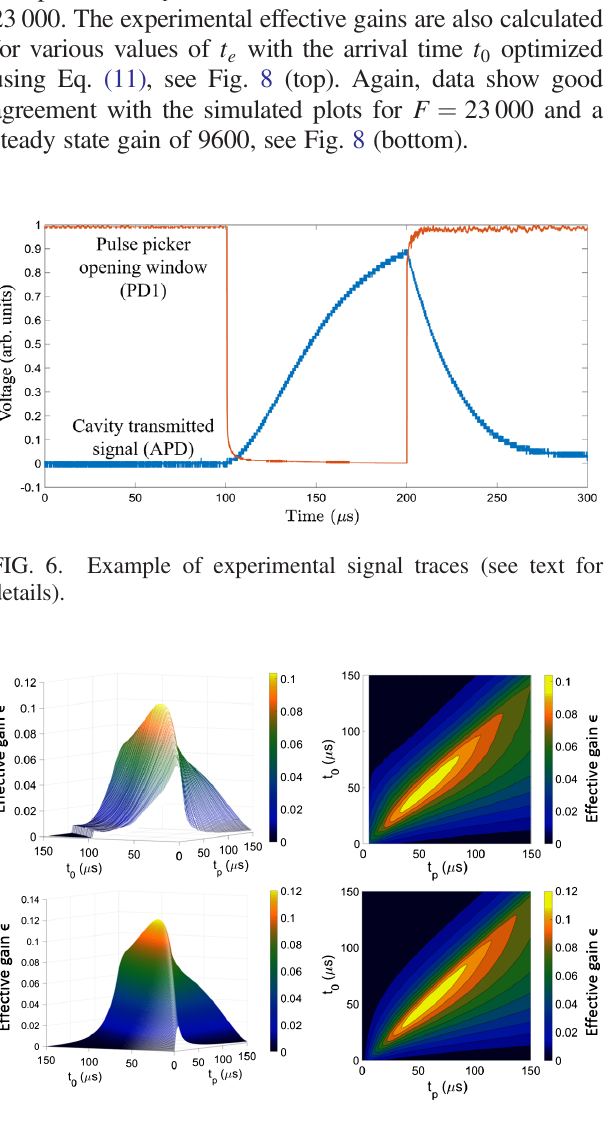
TABLE III. Optimized parameters for the input laser beam for the STAR configuration. P E and the burst duration T b , while P burst N e